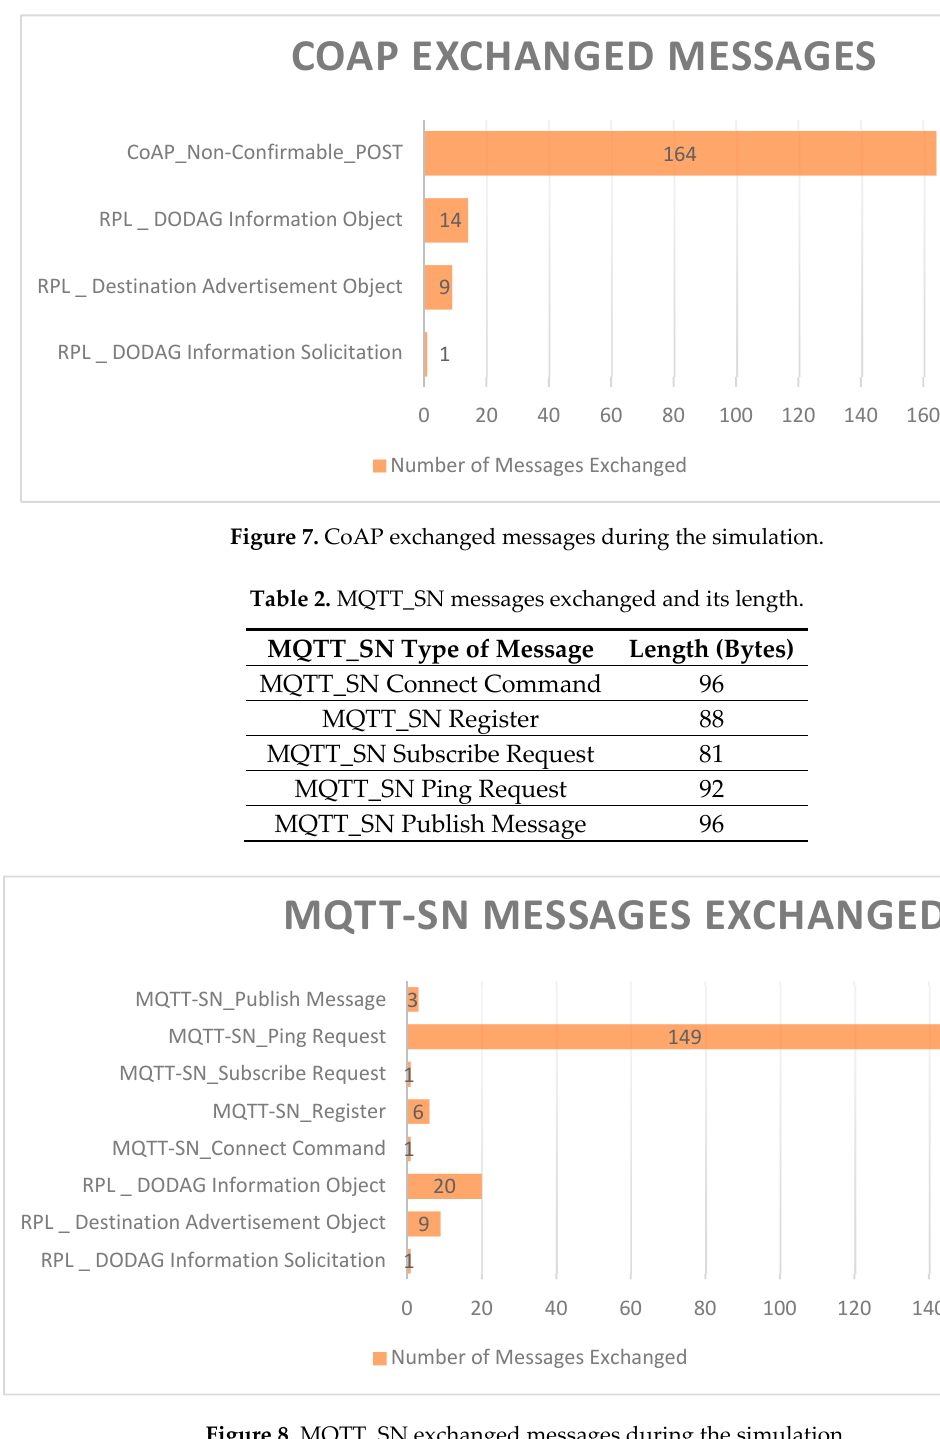
Figure 8. MQTT_SN exchanged messages during the